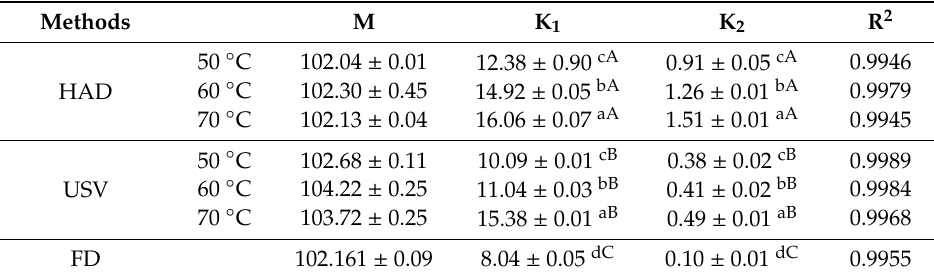
Table 4. Rehydration kinetic parameters for the Peleg model.